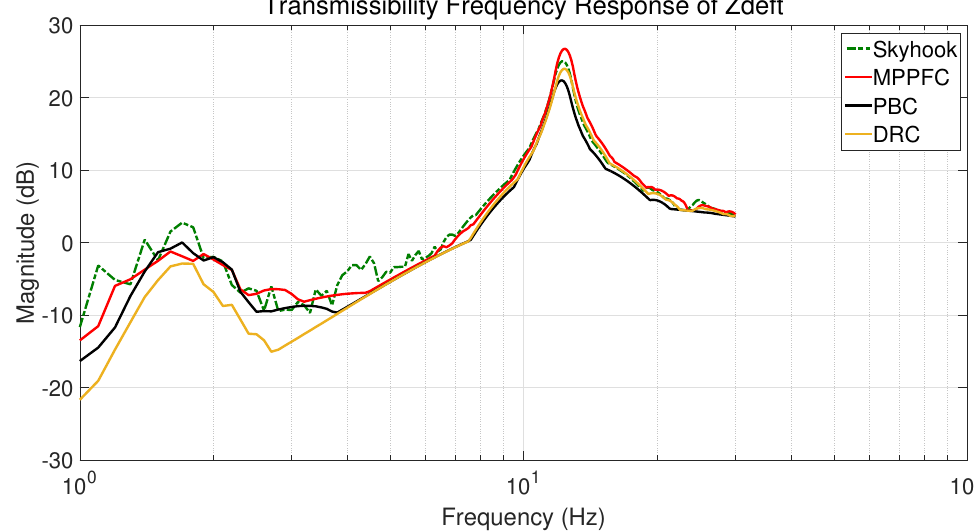
Figure 11. Comparison of TFR of the tyre deflection for different damping control and variable sprung mass.